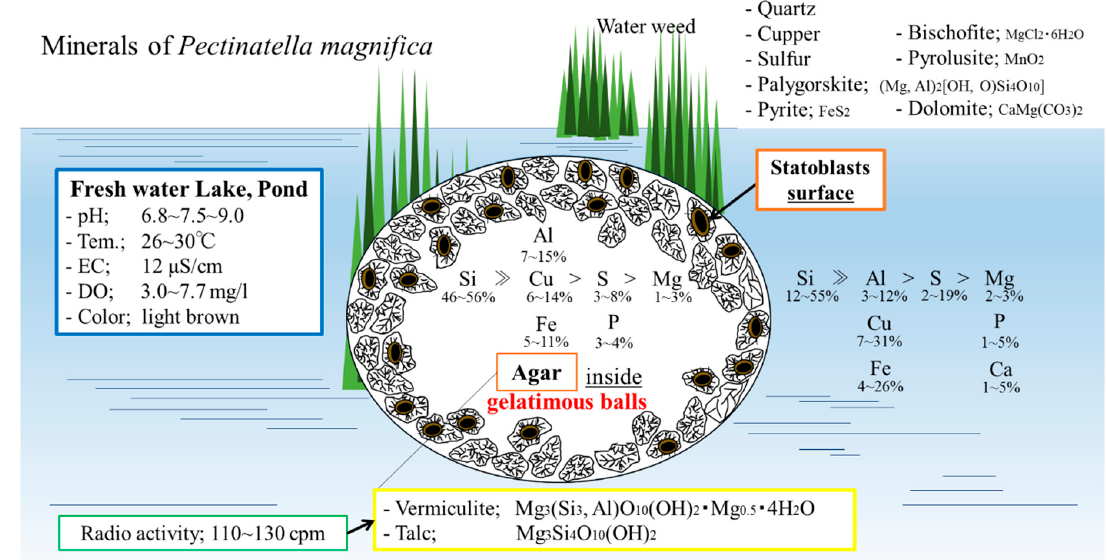
Figure 7. The distribution of elements and minerals inside the bryozoan colony, determined based on chemical data obtained from ICP-MS and SEM-EDS and mineralogical data from XRD. Characteristics of water, such as pH, temperature, EC, DO, and color are excerpted from Hashida et al. [14].